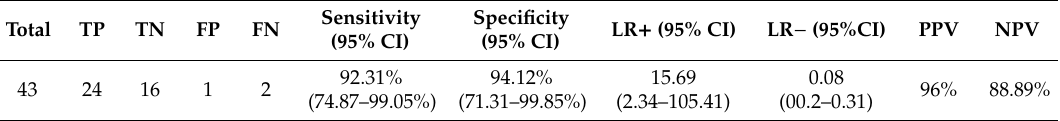
Table 2. Performance characteristic of US for SBO compared to abdominal